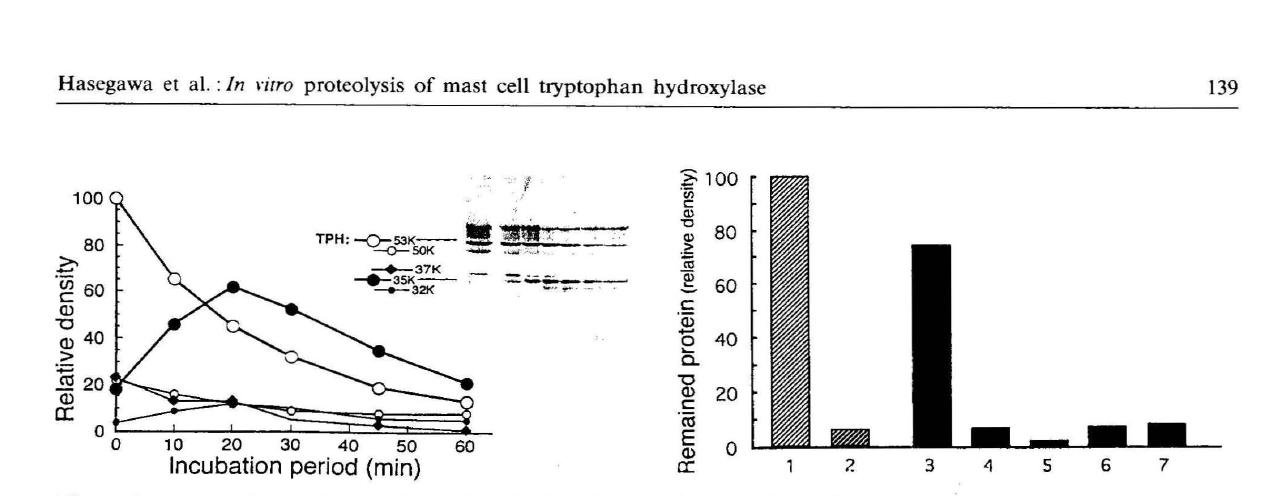
Figure I. In vitro degradation of tryptophan hydroxylase protein : Cell extracts of both P-815 (6 mglml) and RBL2H3 (10 mglml) were prepared separately. They were then mixed at concentrations of 3 mglml each in saline then incubated at 30°C for the indicated period. The mixture was subjected to SDS-polyacrylamide gel electrophoresis for Westernblot analysis using the anti-tryptophan hydroxylase rabbit serum as the primary antibody. TPH: tryptophan hydroxylase (Mr= 53,000). In the inset, the left most lane represents the extracts from P-815 alone. From the next lane to the right, incubations were 0, 10, 20, 30, 45 and 60 min.